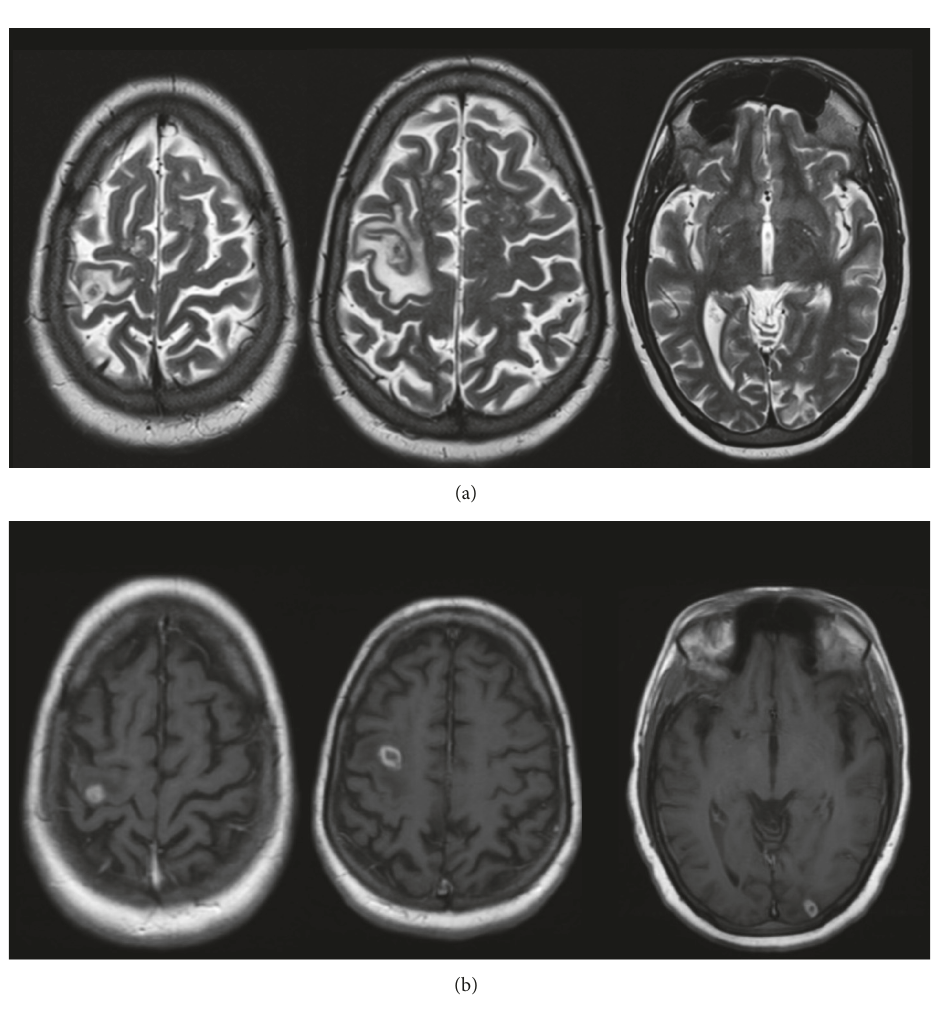
Figure 1: Brain MRI. (a) Axial T2 weighted: three nodular lesions, two in right frontal lobe and one in the left occipital lobe, with hypointense central core, hyperintense peripheral margin, and vasogenic oedema. (b) Axial T1 + gadolinium: ring-enhancing lesions and absent leptomeningeal enhancement.